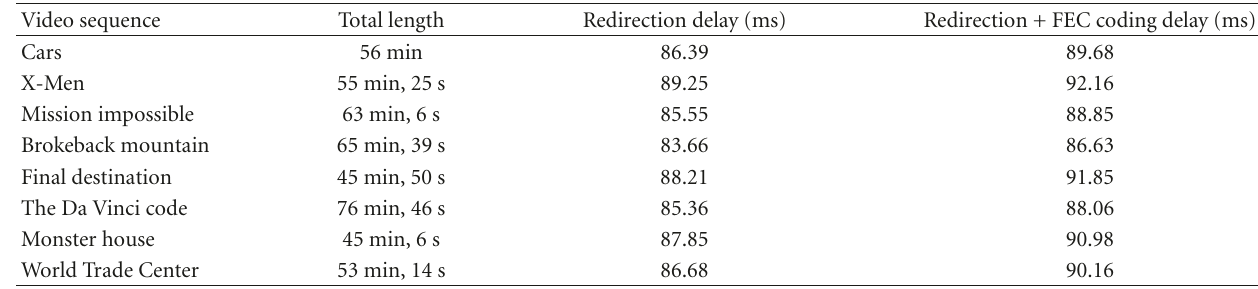
Table 2: Cumulative delay of FEC-on-TQM scheme.